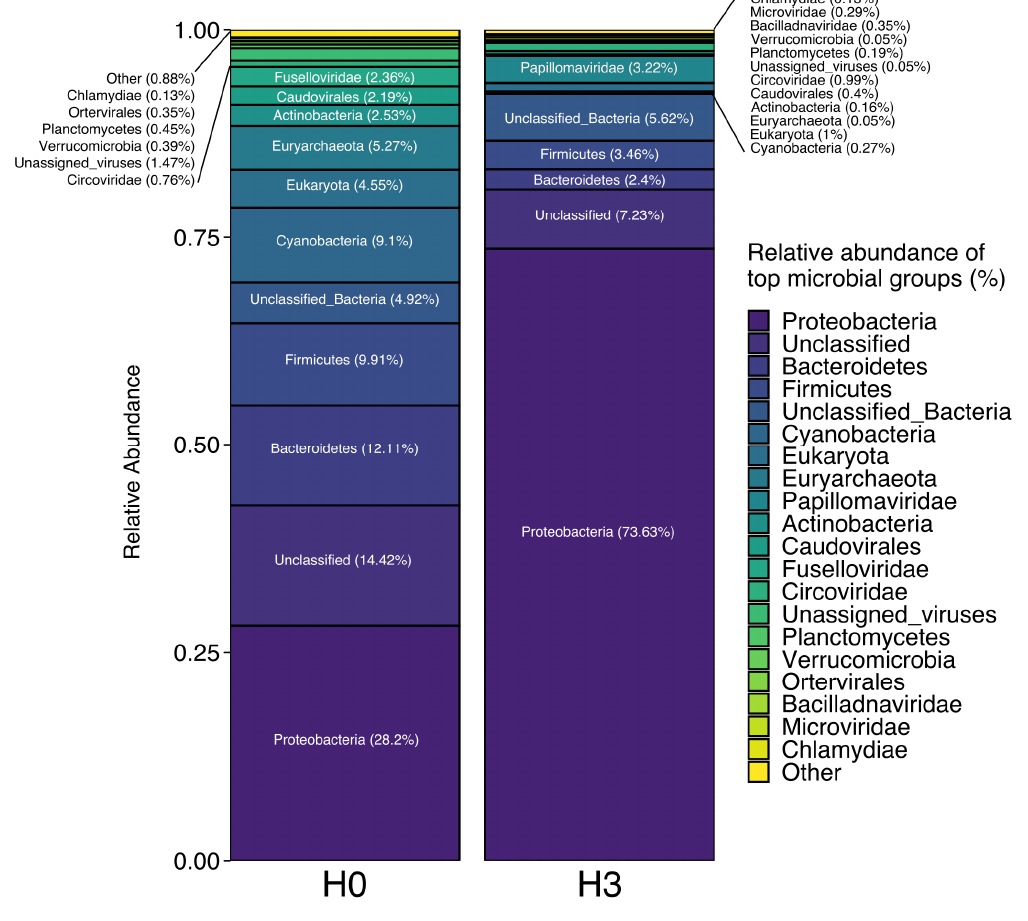
Figure 2. Total community taxonomic bar plot for H0 and H3 metagenomes.